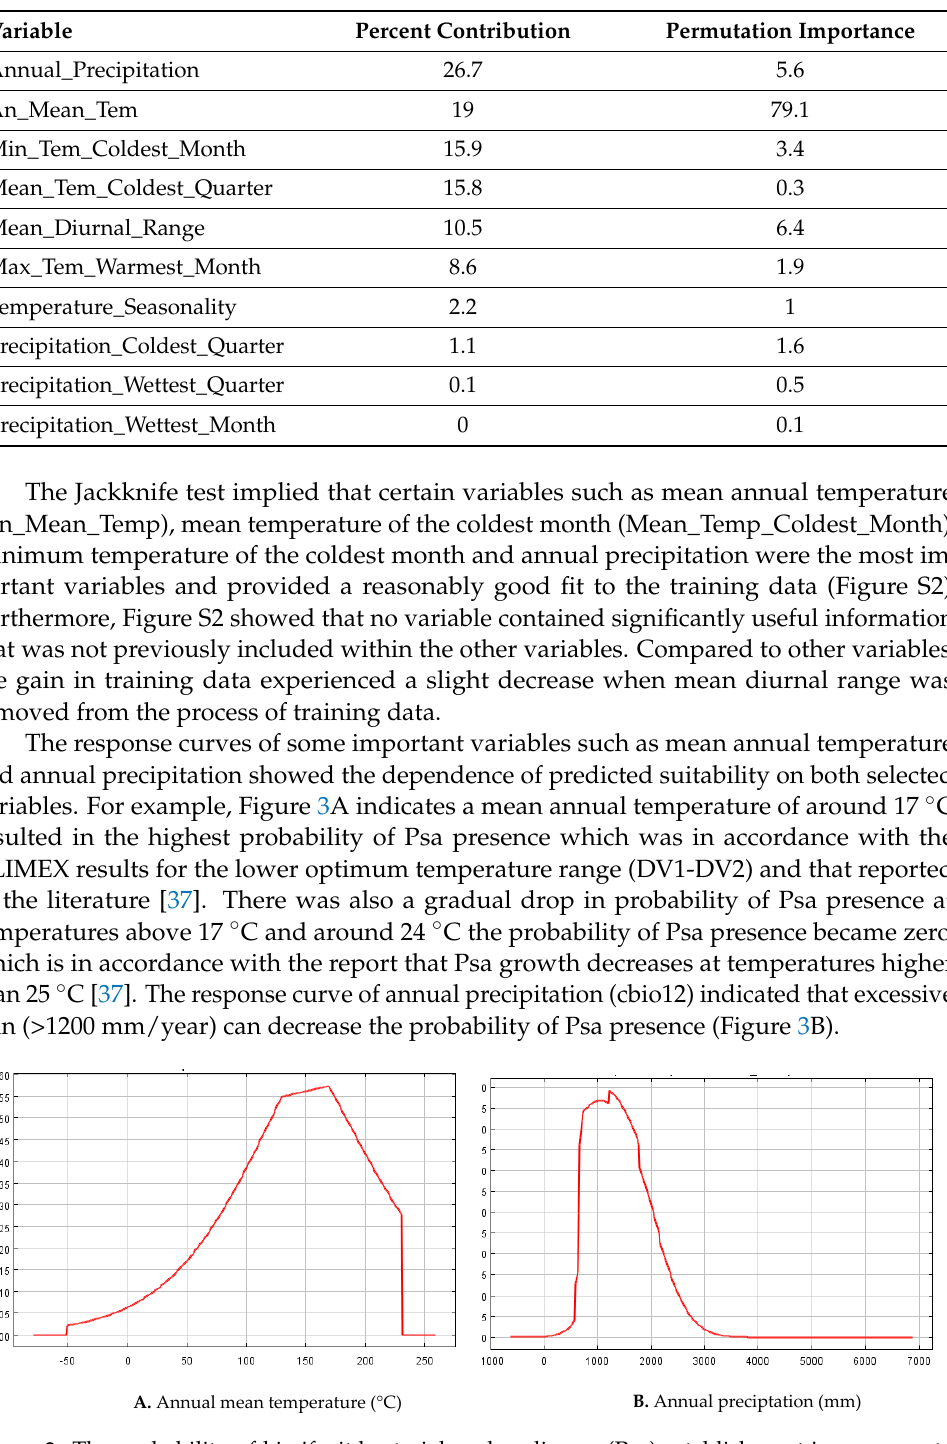
Figure 3. The probability of kiwifruit bacterial canker disease (Psa) establishment in response to annual mean temperature ( A ) and annual precipitation ( B ) according to the model developed by MaxEnt.